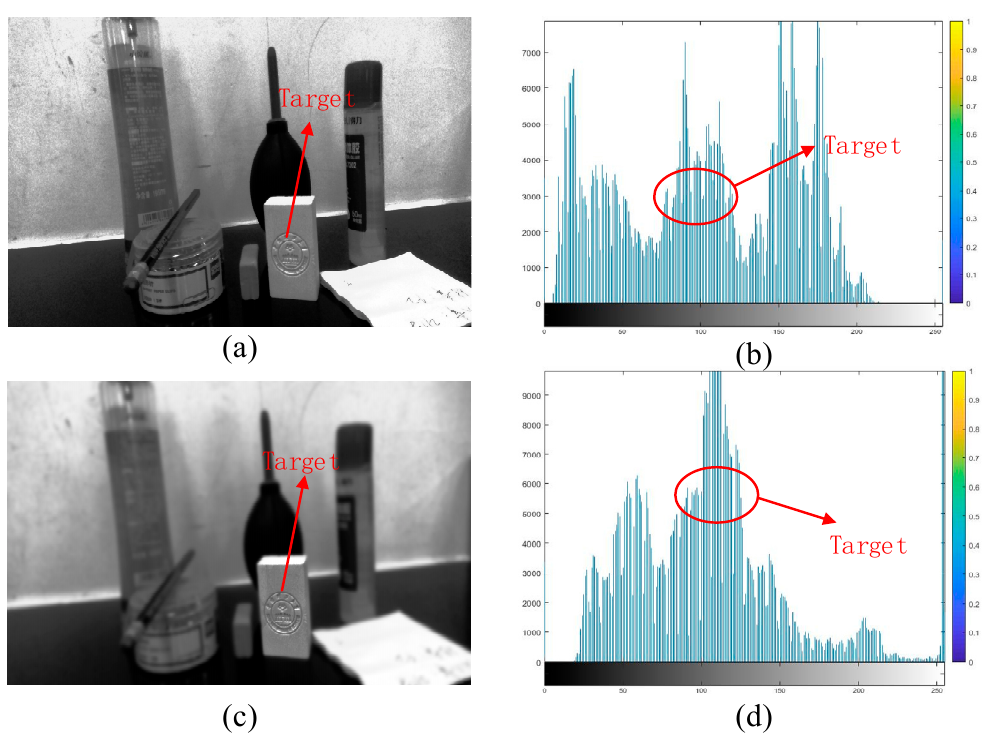
Figure 6. Restore grayscale images and their equalized images. ( a , b ) Shows target original gray scale image and its histogram; ( c , d ) shows after equalized the target image and its histogram.